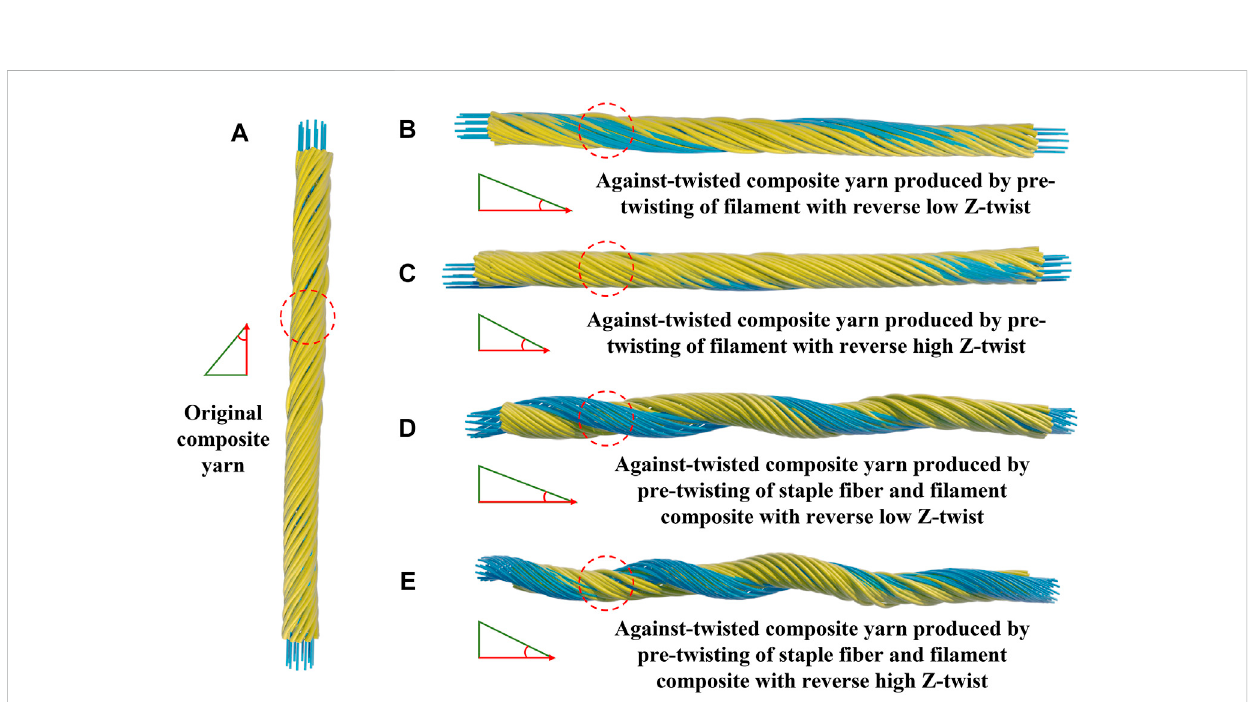
FIGURE 2 Appearance model comparison of yarns spun by different twists: (A) original composite yarn; (B, C) against-twisted composite yarn produced by pre-twisting of fi lament with reverse low and high Z-twists and (D, E) against-twisted composite yarn produced by pre-twisting of staple fi ber and fi lament composite with reverse low and high